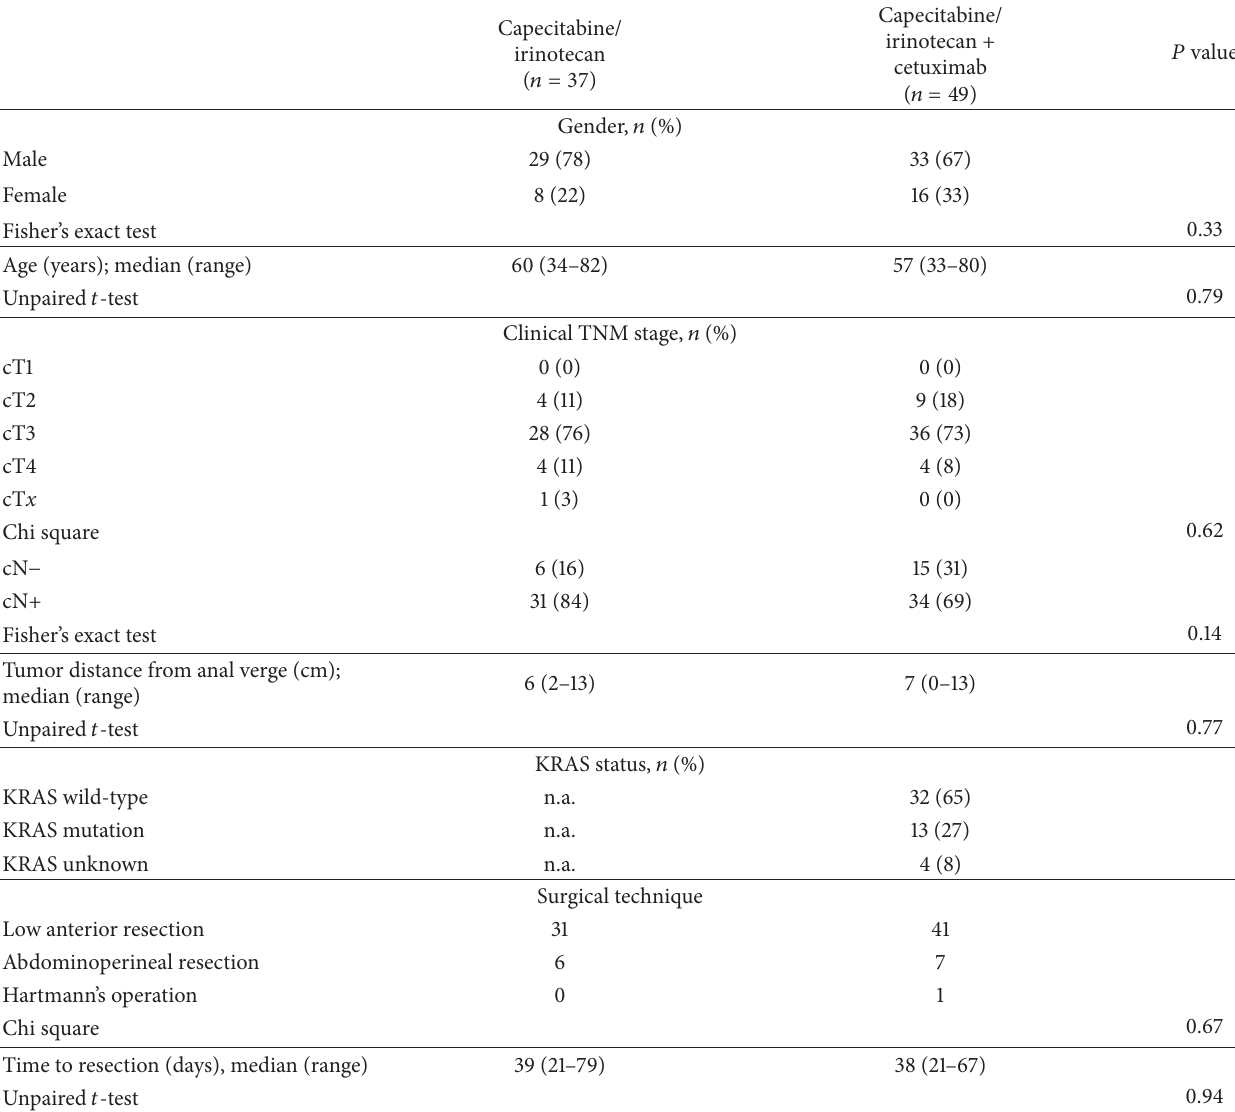
Table 1: Characteristics of patients with locally advanced rectal cancer receiving capecitabine/irinotecan +/ − cetuximab based chemoradio- therapy as preoperative